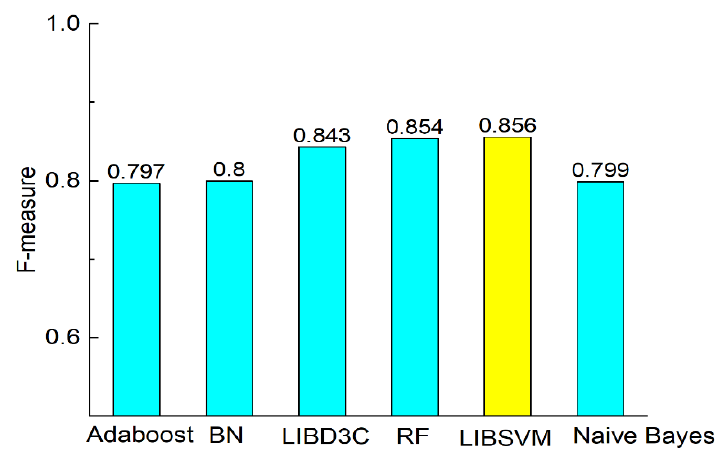
Figure 5. Comparison of recall on different classifiers.